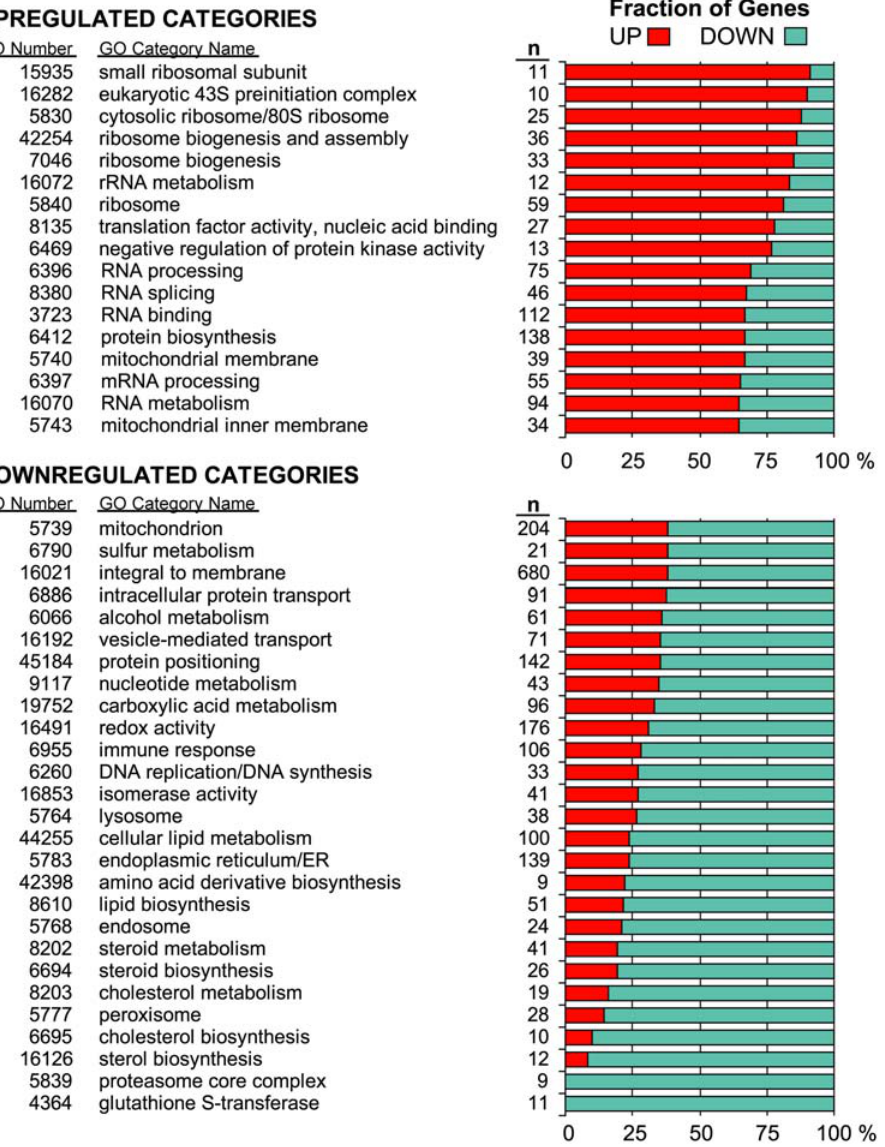
Figure 3. GO categories with largest relative fractions of upregulated or downregulated genes. Each stacked bar graph displays the relative upregulated or downregulated fractions of the total number of genes (n=100%) significantly altered by CR within a given GO category returned by FuncAssociate (adjusted p , 0.05). The upregulated fraction is shown in red and the downregulated fraction is shown in blue.